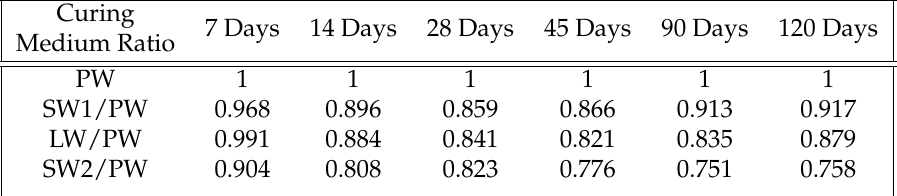
Table 7. Curing medium factor ( α ) for split tensile strength at each curing age